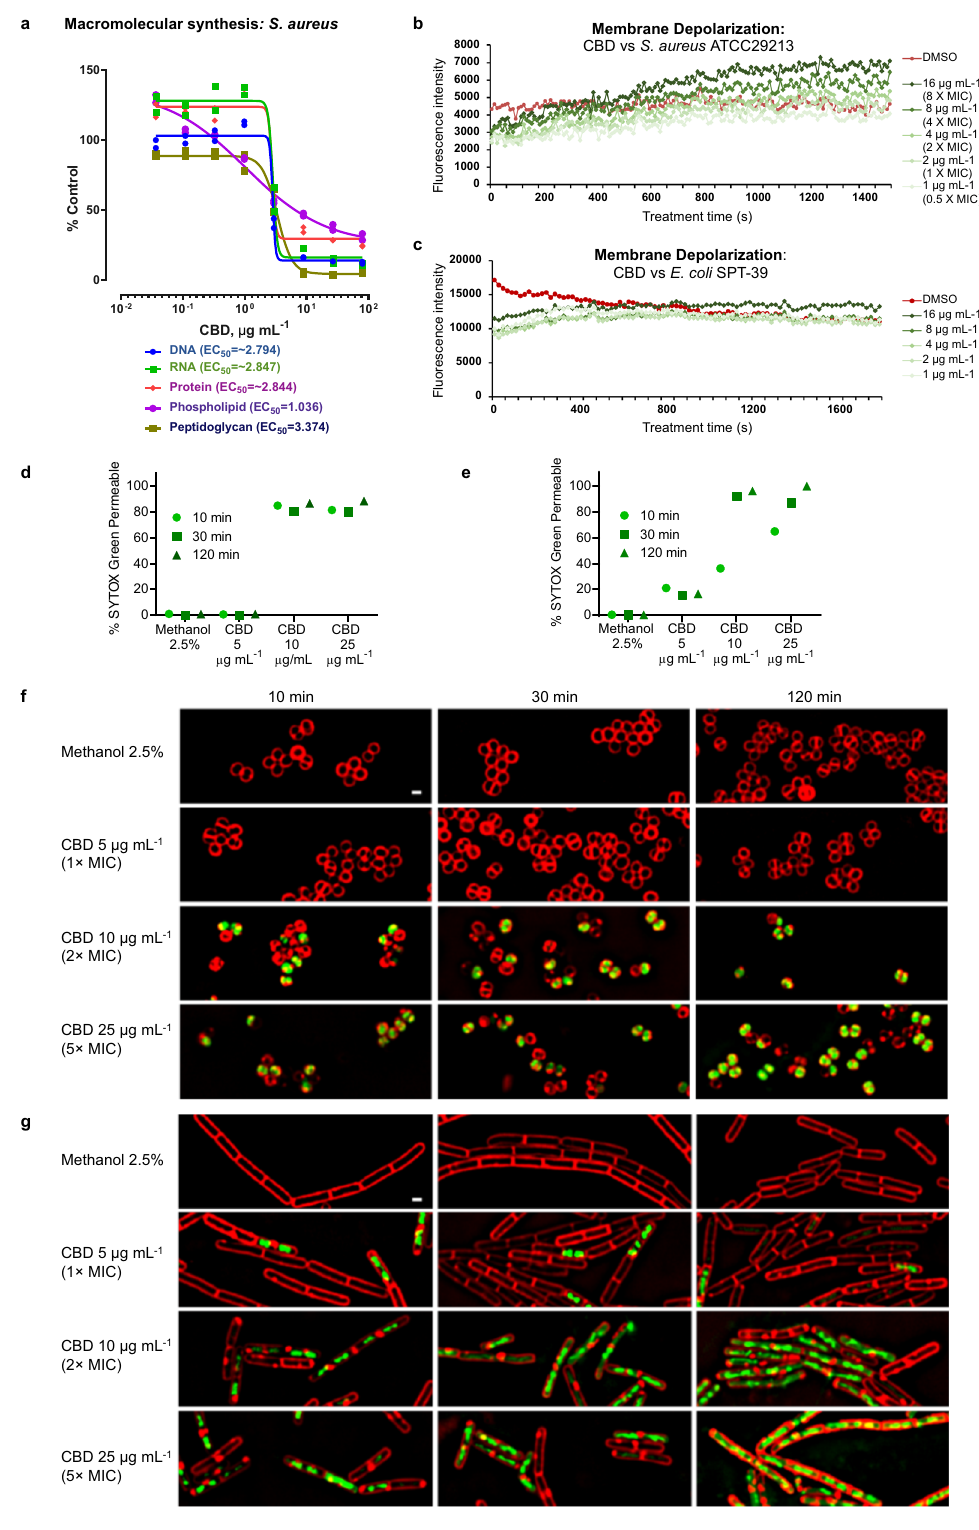
(Table 2). The chemistry of cannabinoids has recently been reviewed 40 . There were clear differences in the structure-activity relationship (SAR) for the Gram-positive activity against MRSA compared to the Gram-negative activity against N. gonorrhoeae . For example, oxidation of the cyclohexene methyl group to a hydro- xymethyl (7-hydroxy-cannabidiol [7-OH-CBD] 2 ) or